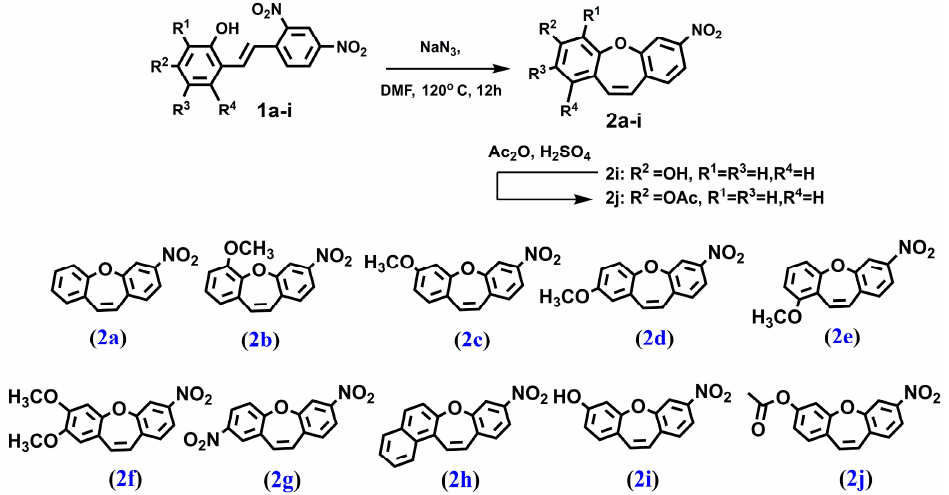
Figure 7. The structure of: 3-nitrodibenzo[ b,f ]oxepine ( 2a ), 6-methoxy-3-nitrodibenzo[ b,f ]oxepine ( 2b ), 3-methoxy-7-nitrodibenzo[ b,f ]oxepine ( 2c ), 2-methoxy-7-nitrodibenzo[ b,f ]oxepine ( 2d ), 1- methoxy-7-nitrodibenzo[ b,f ]oxepine ( 2e ), 2,3-dimethoxy-7-nitrodibenzo[ b,f ]oxepine ( 2f ), 2,7- dinitrodibenzo[ b,f ]oxepine ( 2g ), 9-nitrobenzo[ b ]naphtho[ 1,2-f ]oxepine ( 2h ), 7-nitrodibenzo[ b,f ]oxepin-3- ol ( 2i ) and 7-nitrodibenzo[ b,f ]oxepin-3-yl acetate ( 2j ).